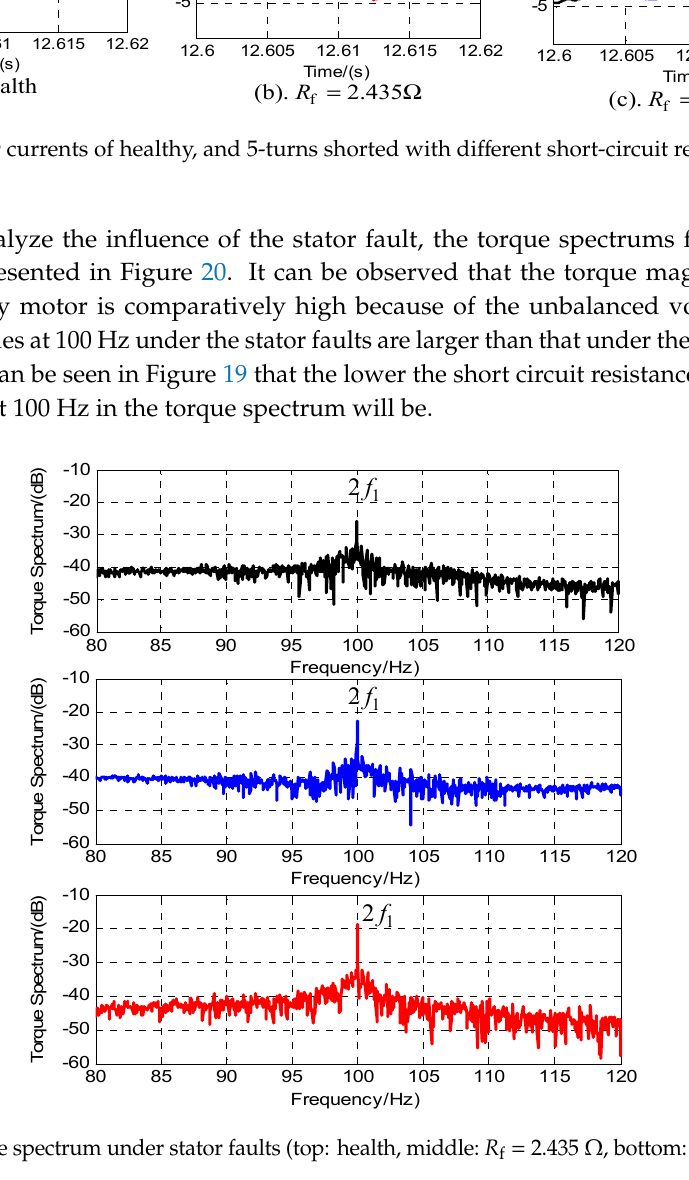
Figure 21. Stator currents of different shorting turns with R f = 0.1 Ω in the induction motor.